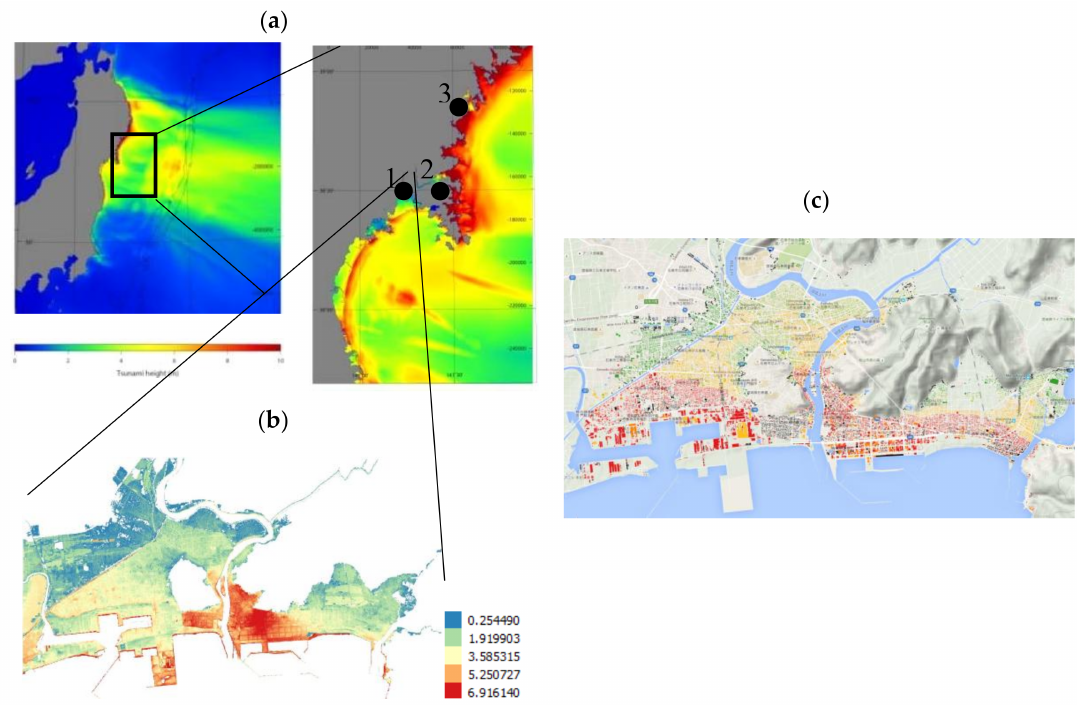
Figure 4. Inundation and damage data referring to the 2011 Japan Tsunami. ( a ) Wave propagation results, with case-study locations indicated: 1 = Ishinomaki, 2 = Onagawa, 3 = Kesennuma. ( b ) Inundation simulation results for Ishinomaki ( c ) Building damage data with buildings coloured from green (damage state (DS)1) to red (DS5) with black indicating